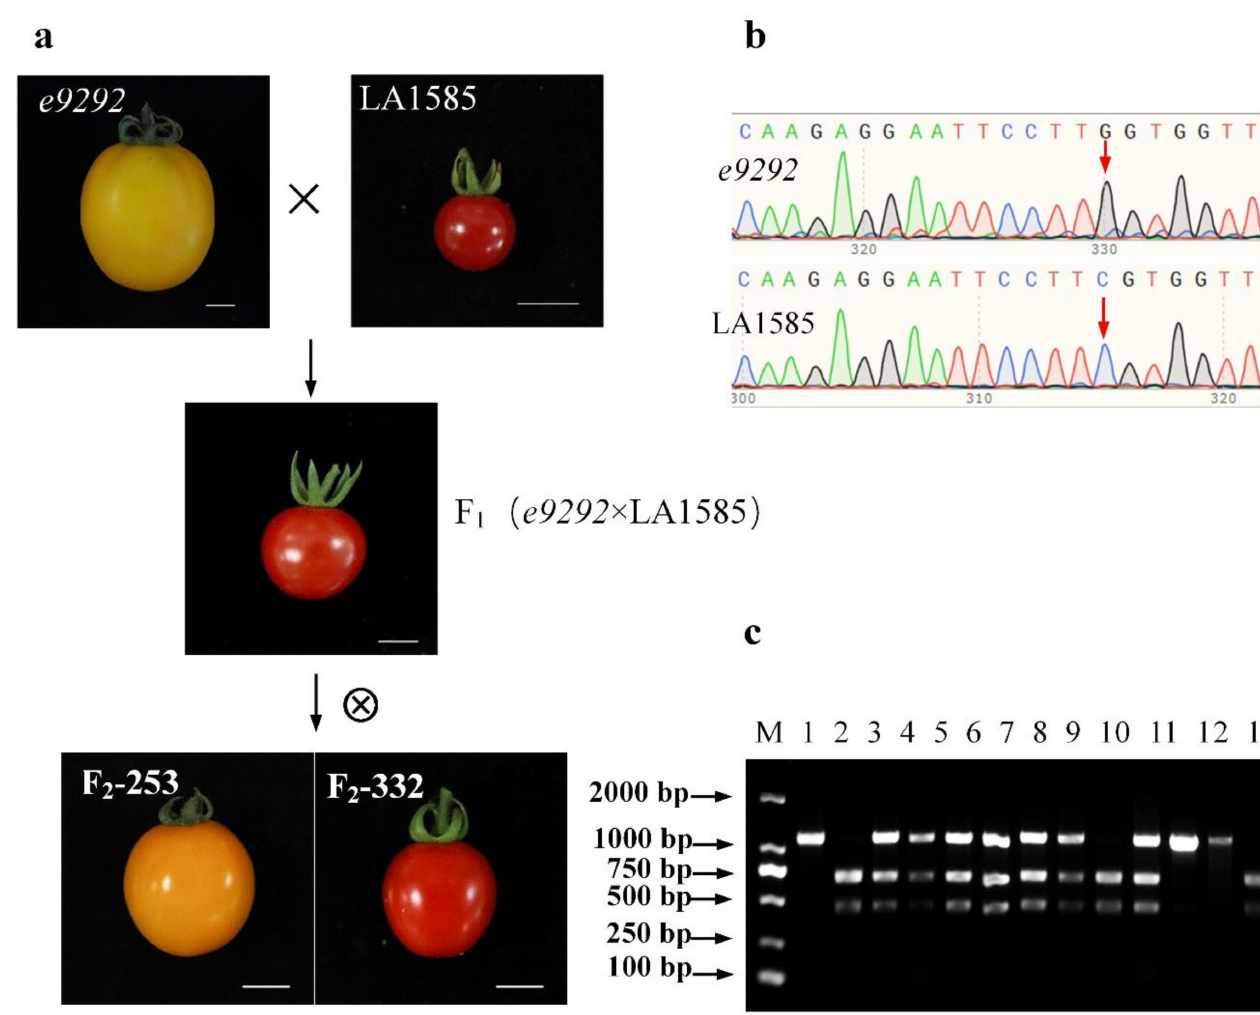
Figure 1. Creation of populations of different generations resulting from distant hybridization and identification of features caused by hybridization. ( a ) Fruit color and size of the Solanum lycopersicum e9292 mutant used as the pistil parent and S. pimpinellifolium LA1585 used as the pollen parent, along with subsequent generations (scale bar = 1 cm). ( b ) The SNP (single-nucleotide polymorphism) difference found in TG 294 at chromosome 8 between e9292 and LA1585. ( c ) Identification of genomic DNA features caused by hybridization using a CAPS marker. Lane M, DL2000 DNA ladder. Lanes 1–13: e9292 , LA1585, F 1 ( e9292 × LA1585), F 2 -259, F 2 -280, F 2 -292, F 2 -318, F 2 -332, F 2 -253, F 2 -266, F 2 -299, F 2 -328, and F 2 -330,